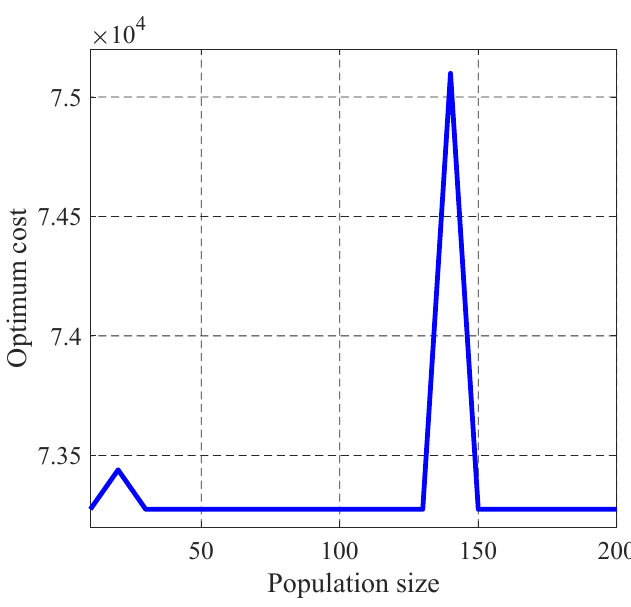
Figure 18. Variation of the optimum solution versus population size.